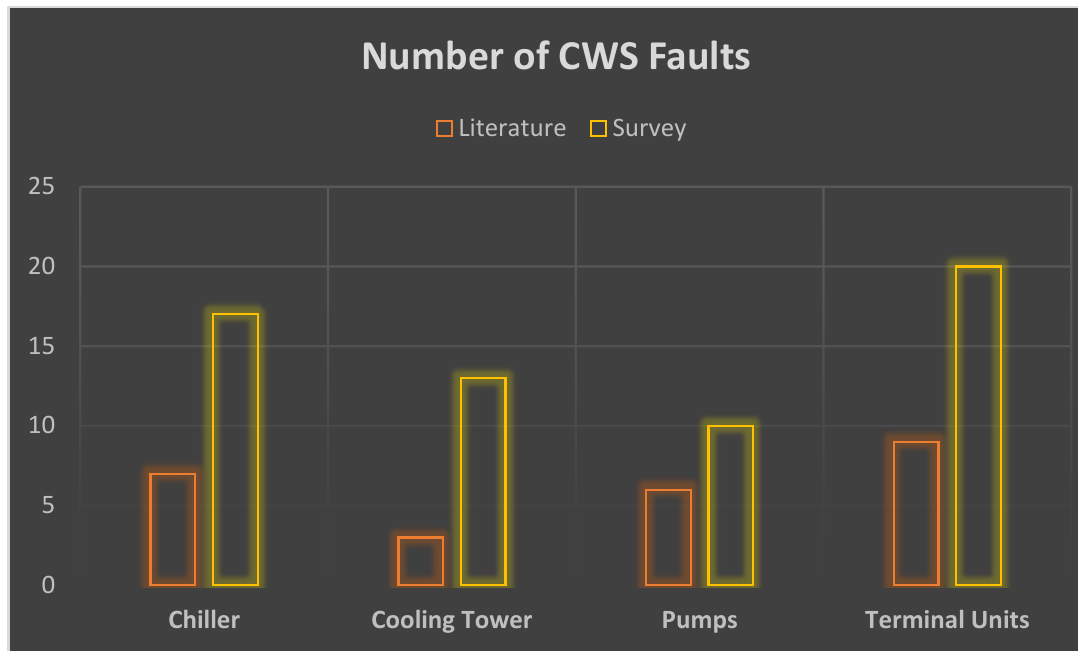
Figure 6. Faults presented in the literature.